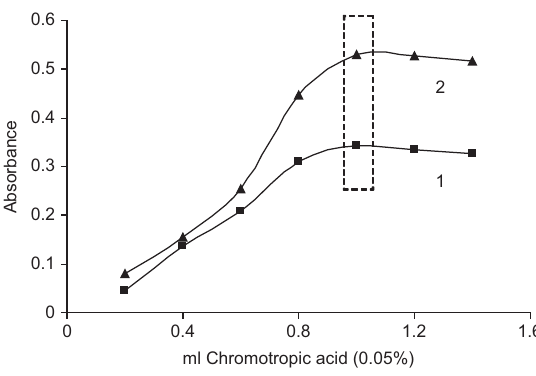
Figure 2 Effect of chromotropic acid concentration used in the reaction on the absorption signal [aqueous solution with nitrate concentration (1) 6.25 mg l -1 , and (2) 9.80 mg l -1 ].